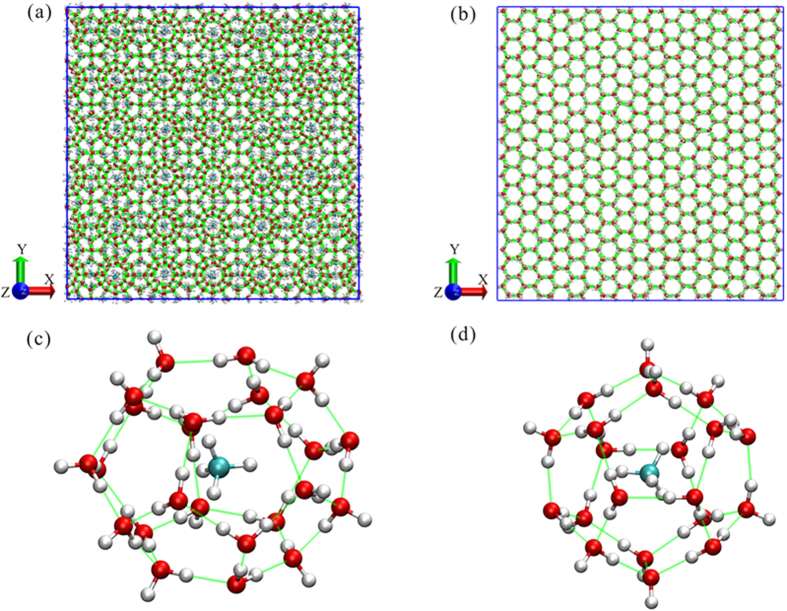
Molecular structures of (a) methane hydrate (sI) and (b) normal ice (Ih). (c) Large (51262) and (d) small (512) methane hydrate cages.